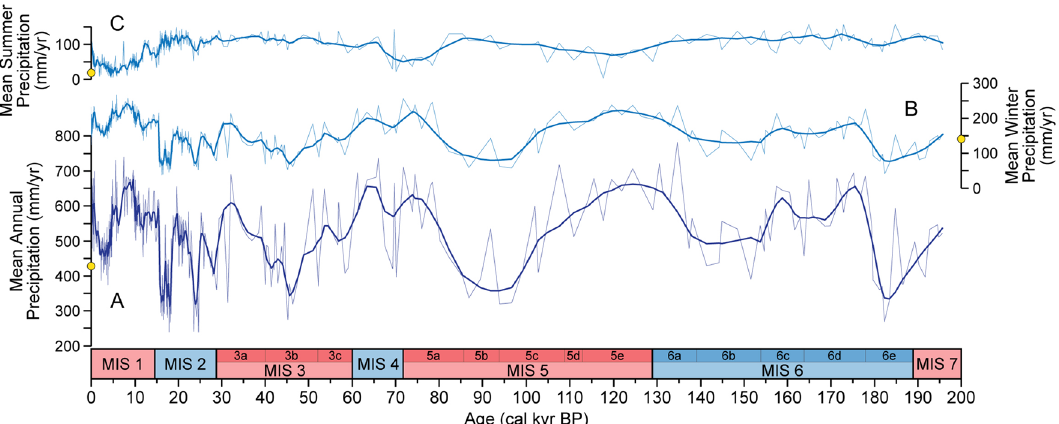
Figure 2. Quantitative reconstruction results from the Padul record for the last 200 kyr: ( A ) Mean annual precipitation (MAP), ( B ) mean winter precipitation (MWP) and ( C ) mean summer precipitation (MSP) reconstructions (in mm/yr). Light lines show the raw data, whereas the darker lines indicate the locally estimated scatterplot smoothing (LOESS) (span 0.02). Yellow dots show the present mean annual, winter and summer precipitation recorded at the agroclimatic meteorological station from Padul between 2001 and 2022 (426, 141 and 12 mm/yr,